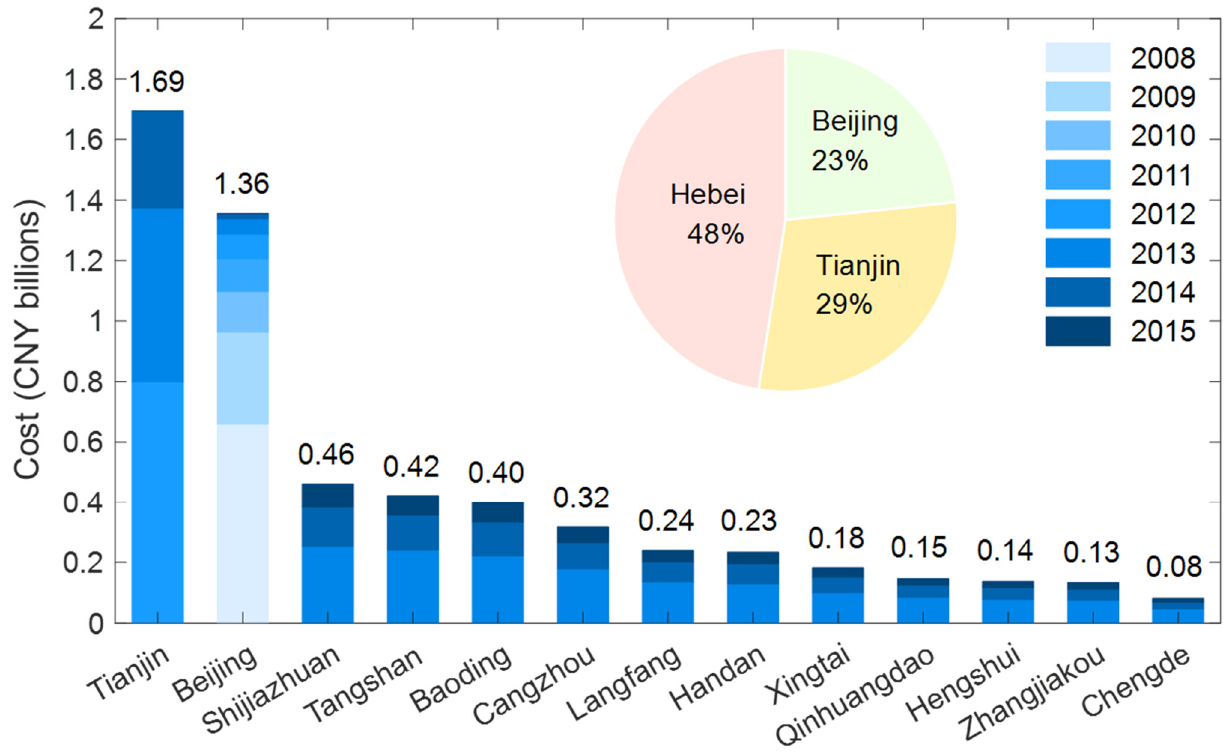
Figure 3. Cost of the HEV driving area restriction